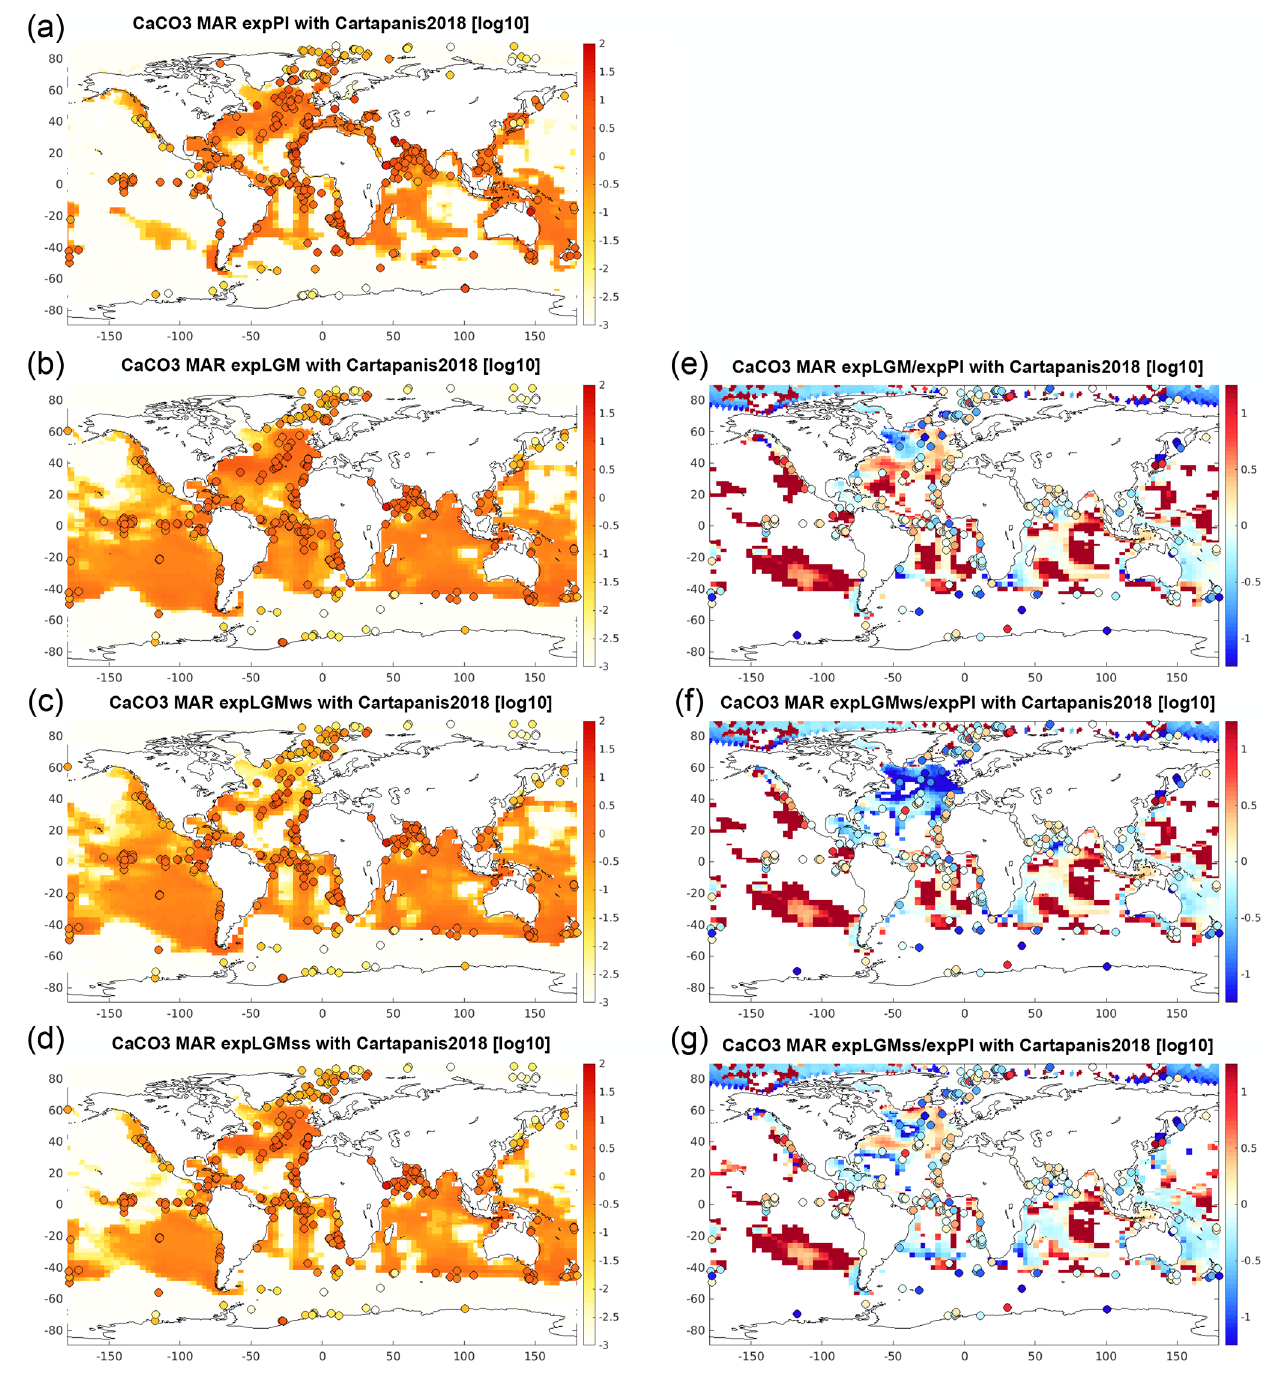
Figure 11. Mass accumulation rate (MAR) of CaCO 3 in the upper sediment simulated with MEDUSA. The left column shows the absolute values (gcm − 2 kyr − 1 ) for (a) expPI, (b) expLGM, (c) expLGMws, and (d) expLGMss on a logarithmic scale with overlaid dots indicating the observation-based data by Cartapanis et al. (2018). The ratio of MAR in the respective LGM runs to that in the expPI run is shown in the right panels: (e) expLGM, (f) expLGMws, and (g) expLGMss. For the ratio, the locations with MAR less than 1 × 10 − 10 gcm 2 kyr − 1 were removed from the plot domain to highlight regions of large